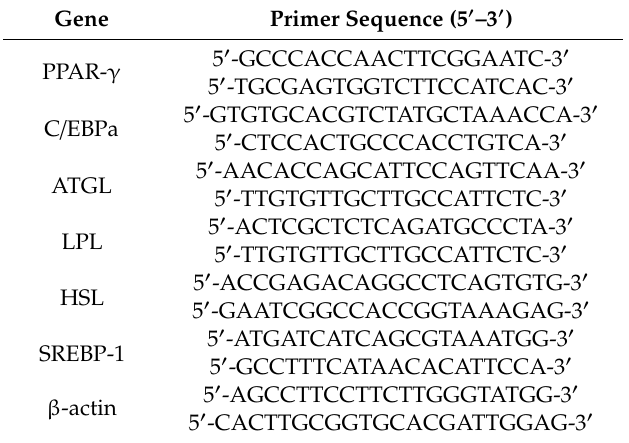
Table 1. PCR primers and conditions used for real-time PCR in 3T3-L1 adipocytes. Gene Primer Sequence (5 (cid:48) –3 (cid:48)